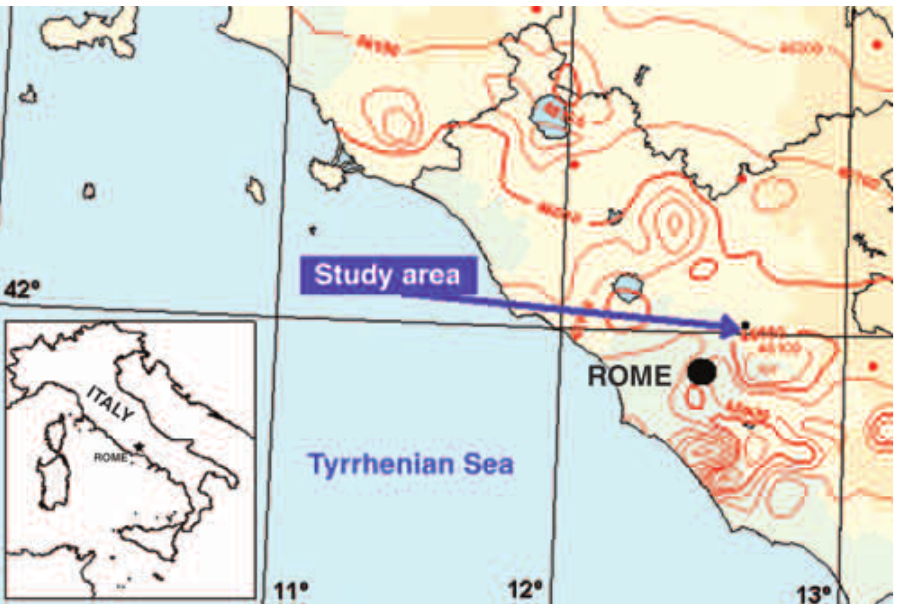
Fig. 1. Location of study area. Riano Flaminio is a small town near Rome (Central Italy). Extracted from the Italian Geomagnetic Total Field map at year 2000.0 (Coticchia et al. ,